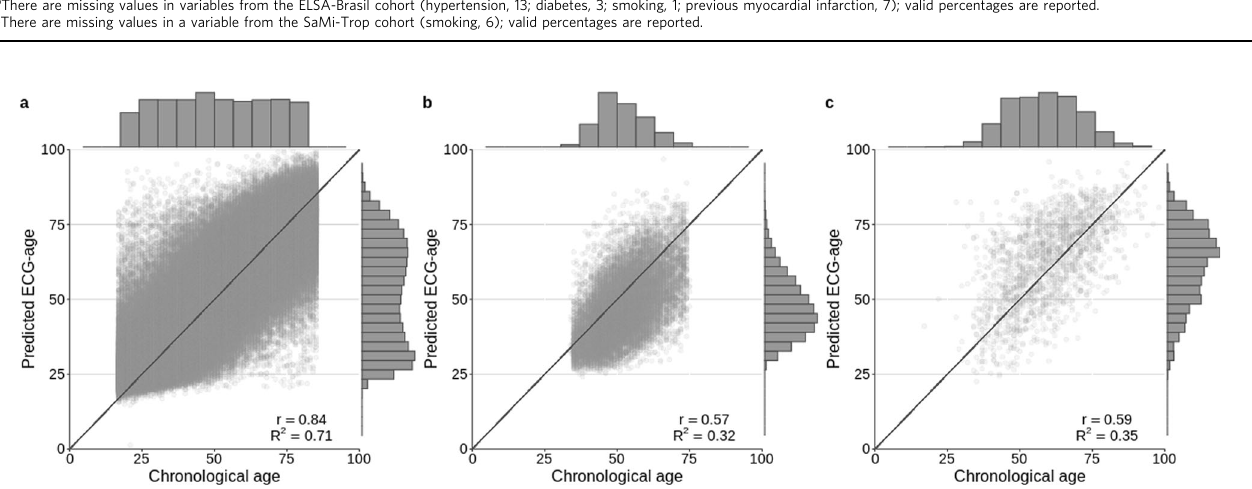
Fig. 1 Chronological vs ECG-age. The scatter plots display the relation between the predicted ECG-age and chronological age. The black line is the identity line. The lateral histograms show the distributions of predicted ECG-age and chronological age among patients of the cohorts. a CODE-15% cohort, b ELSA-Brasil cohort, c SaMi-Trop cohort. The mean predicted ECG-age was 52 (s.d. 19), 47 (s.d. 11), 63 (s.d. 14), for CODE-15%, ELSA-Brasil cohort and SaMi-Trop cohort, respectively. The R 2 (Pearson correlation) was 0.71 ( r = 0.84) in the CODE-15%, 0.32 ( r = 0.57) in ELSA-Brasil cohort and 0.35 ( r = 0.59) in the SaMi-Trop